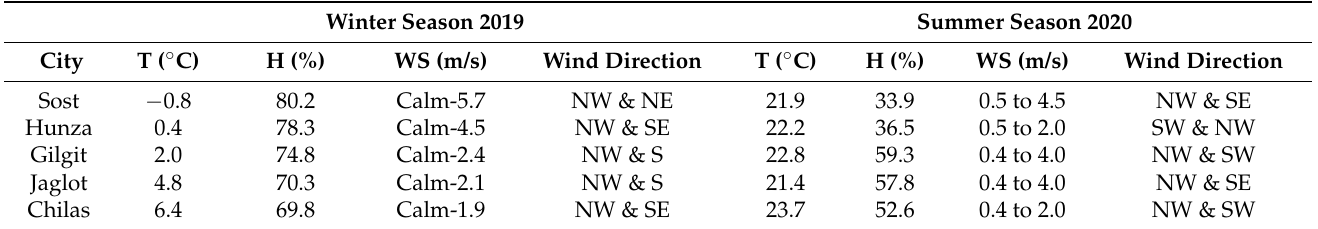
Table 4. Meteorological conditions at the study locations during the winter and summer